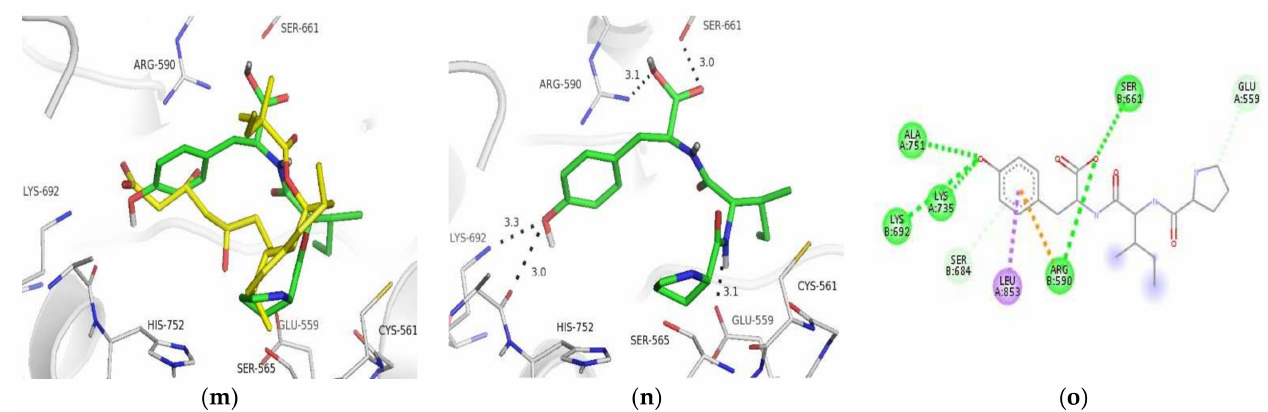
Figure 1. Docking analysis of simvastatin and the peptides with the HMG-CoA reductase catalytic complex (PDB ID: 1HW9) using the AutoDock Vina software. ( a ) Best-ranked pose for simvastatin (yellow); ( b ) the crystallographic binding profile of simvastatin (grey) in the HMG-CoA reductase active site; and ( c ) 2D diagram of simvastatin interactions. Orientations of QGF, IAF, QDF, and PIY docked into the HMG-CoA reductase active site are shown in comparison to the bioactive simvastatin conformation in ( d , g , j , m ), respectively; their predicted binding profile in the active site is shown in ( e , h , k , n ), re- spectively; and the 2D diagram of the peptides interactions is shown in ( f , i , l , o ), respectively. The protein structure is depicted with selected residues highlighted as sticks (carbon = light grey) and ligands are represented as sticks (carbon = yellow or grey; oxygen = red; and nitrogen = blue). All images were generated using PyMOL 0.99r software (Scripps Research Institute, San Diego, CA,